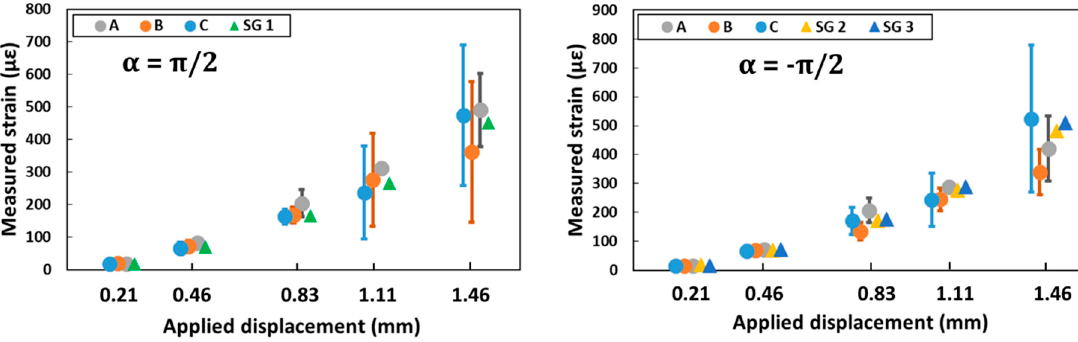
Figure 9. Comparison of strain gauges (SGs) and optical fiber (OF) measurements.